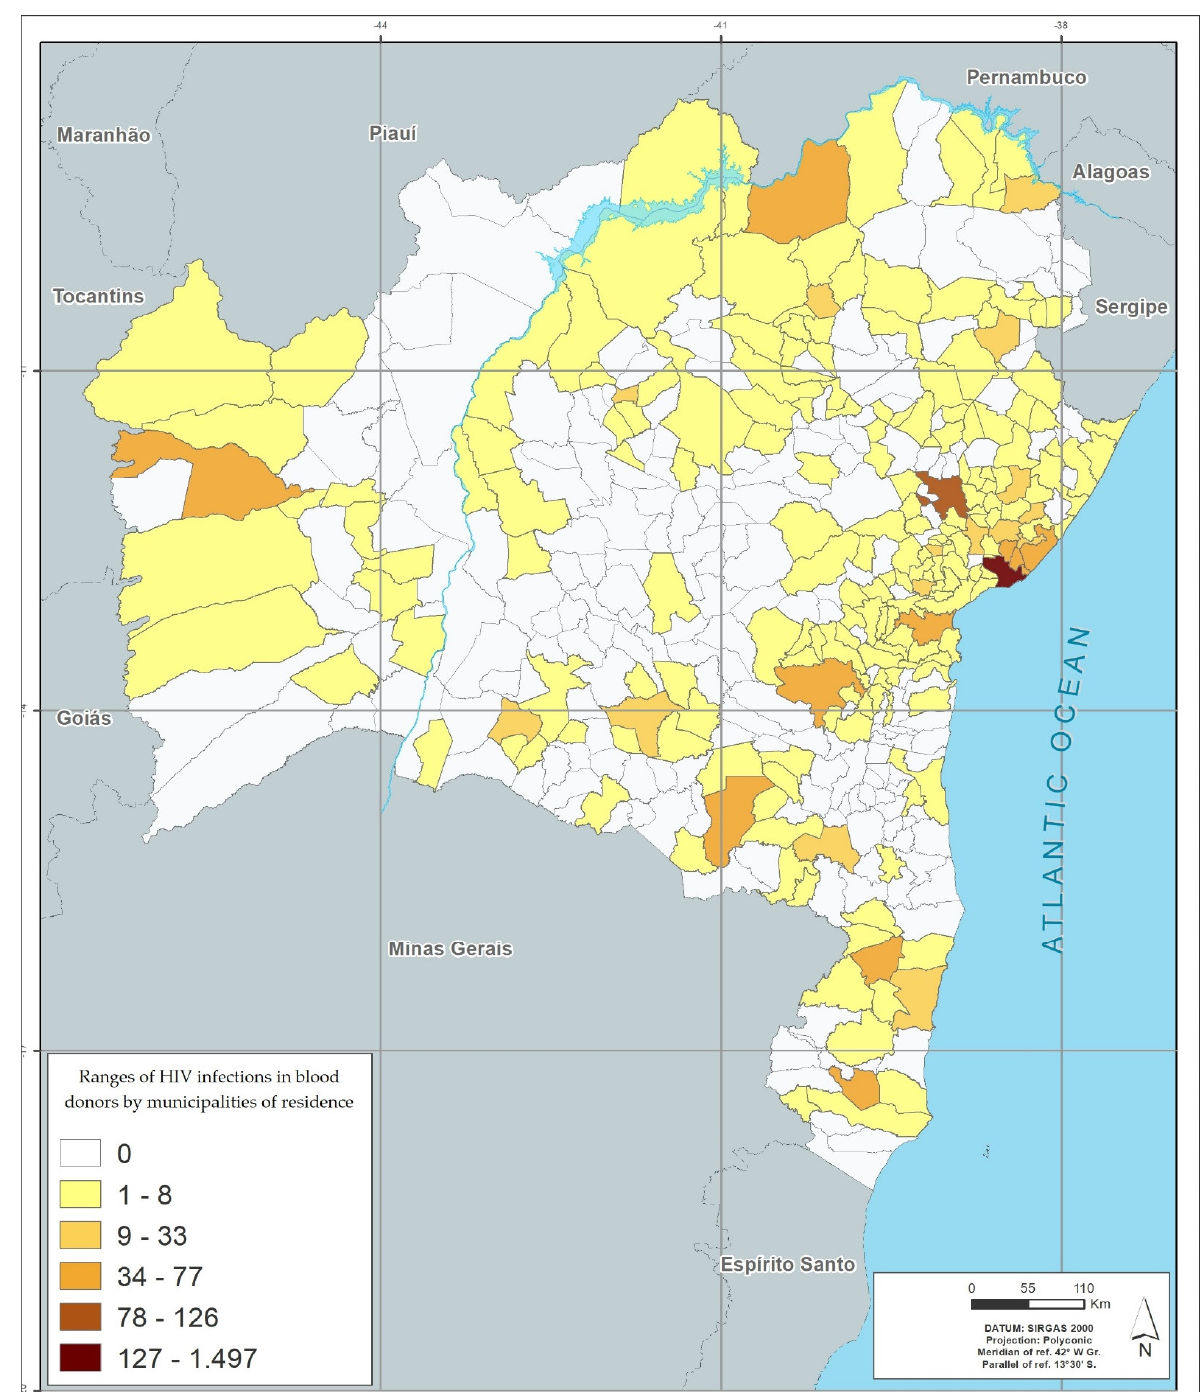
Figure 1. Infection’s rates in absolute numbers for HIV by municipalities of residence in blood donors between 2008-2017.